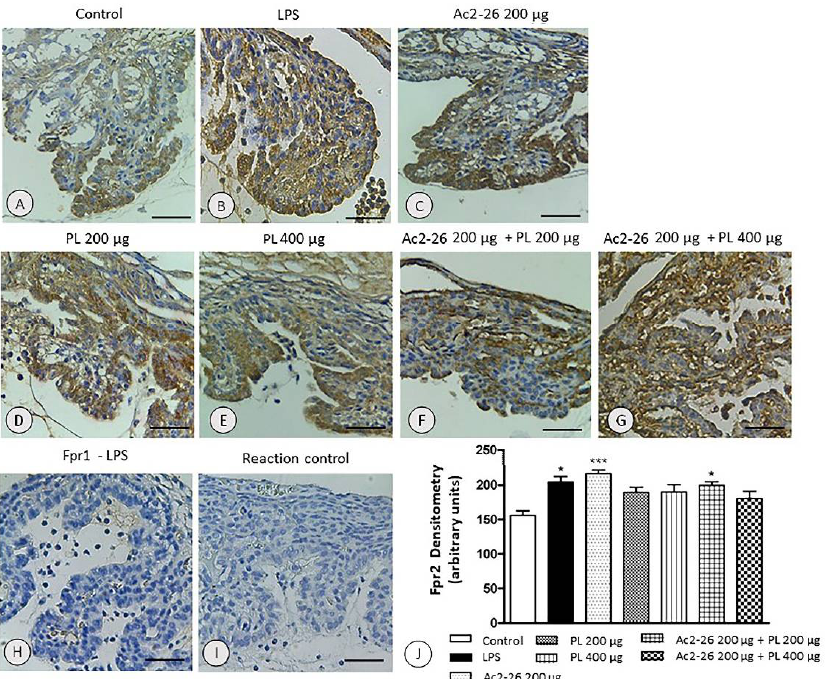
Figure 7. Specific expression of fpr2 in ocular tissues. Strong immunoreactivity for fpr2 in the LPS ( B ) and Ac2-26 ( C ) groups. Similar expressions were found among the control ( A ), PL ( D , E ), and Ac2-26 + PL ( F , G ) groups. Absence of labeling for fpr1 receptor ( H ) and in control of the reaction ( I ). Counterstaining: hematoxylin, bars: 10 µm. Densitometric analysis of fpr2 ( J ). Results were obtained as mean ± SEM of the densitometric index of the eyes of the control rats, untreated uveitis (LPS), and treated groups (Ac2-26 200 µg, PL 200 µg, PL 400 µg, Ac2-26 + PL 200 µg, and Ac2-26 + PL 400 µg) ( n = 10 animals/group). *** p < 0.001 and * p < 0.05 versus control.